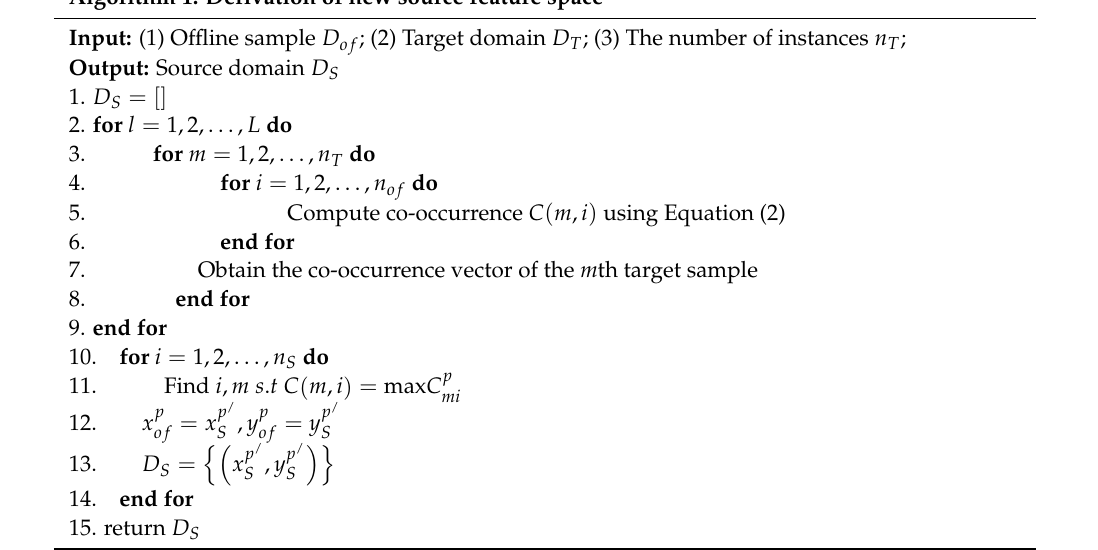
Algorithm 1. Derivation of new source feature